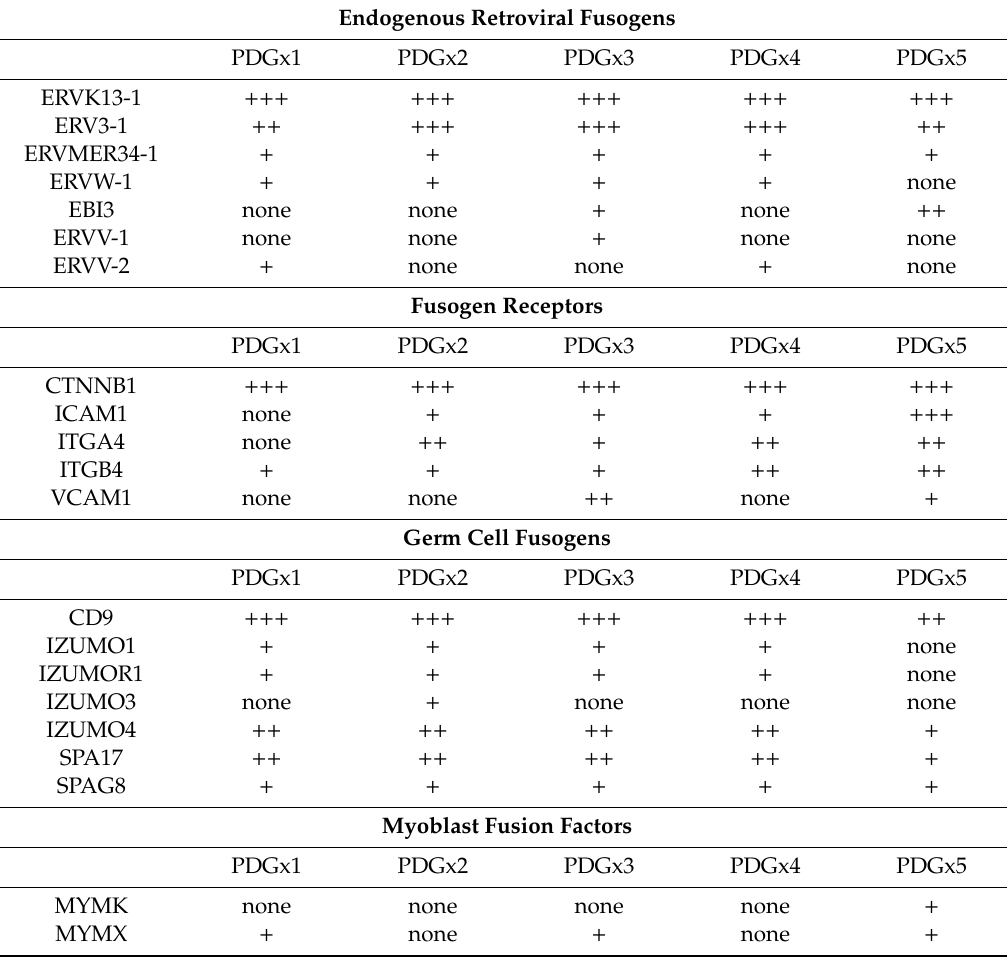
Table 1. Expression of the fusogens and the fusogen receptor transcripts in PDGx neurospheres of di ff erent subtypes: proneural (PDGx1, PDGx2), classic (PDGx3, PDGx4), and mesenchymal (PDGx5).